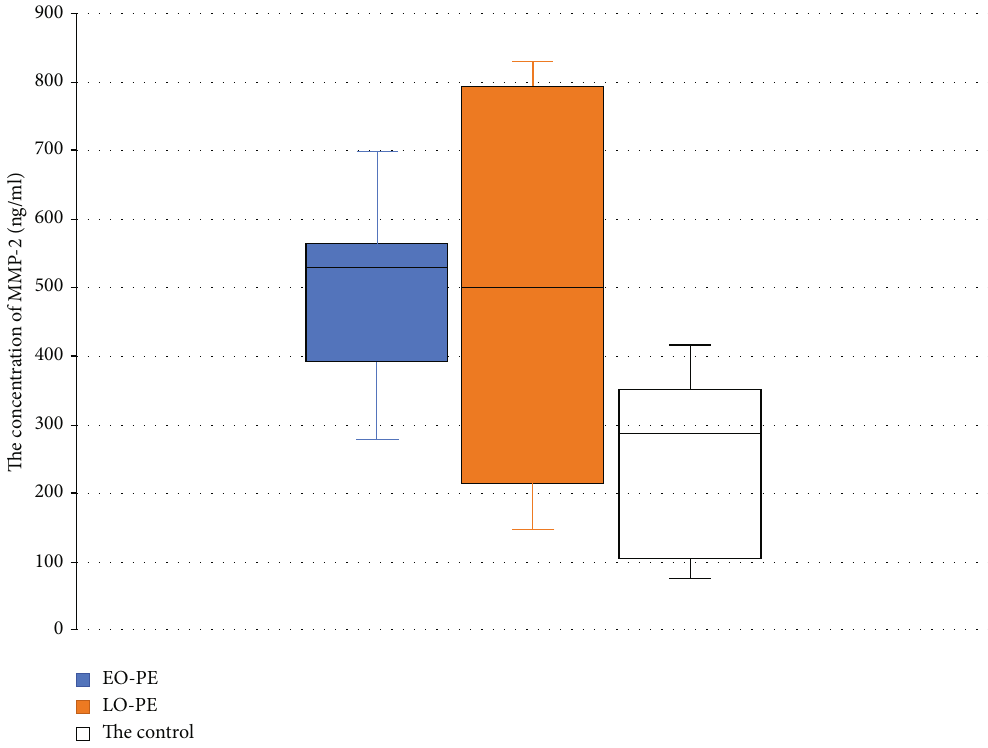
Figure. 2: Comparison of the levels of MMP-2 in the severe EO-PE and LO-PE subgroups and the control group. We did not observe a di ff erence in the levels of MMP-2 in the EO-PE and LO-PE subgroups. Box plot showing the median (bold horizontal line), interquartile range (box), and total range (whiskers).